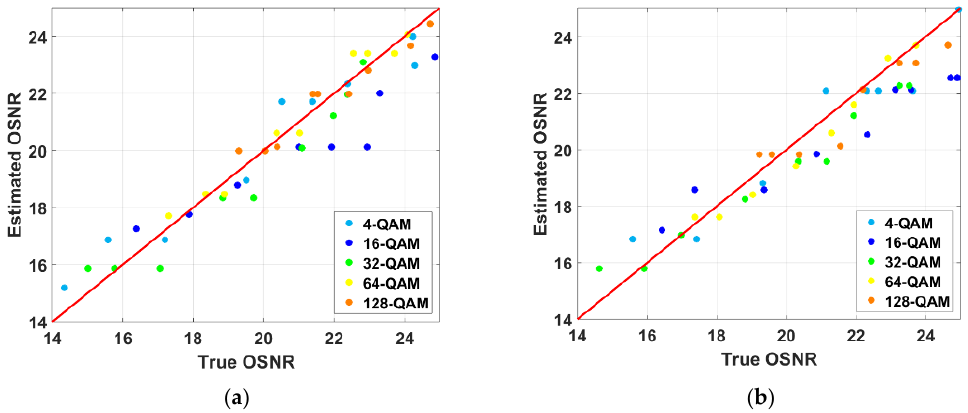
Figure 9. Estimated versus true OSNRs for ( a ) OBTB and ( b ) 25 km SSMF configurations.